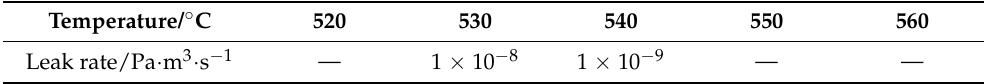
Table 5. Air tightness of the sealed joints at di ff erent sealing temperatures.